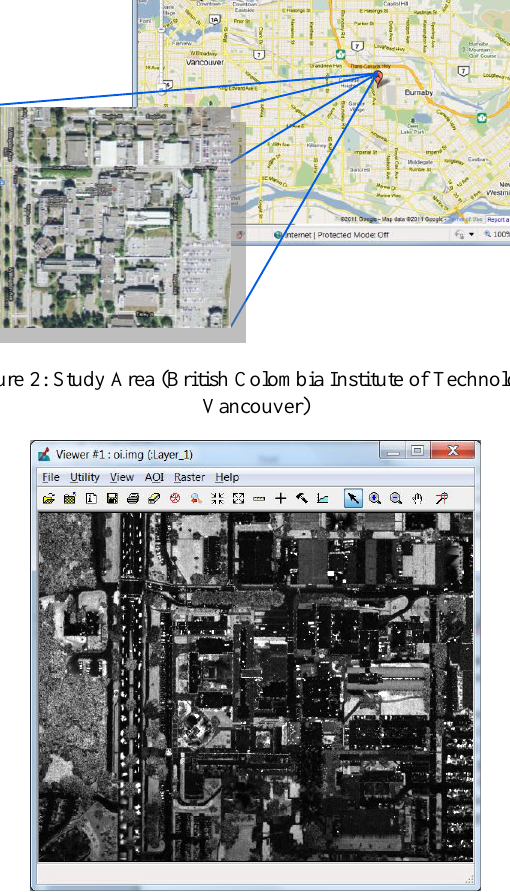
Figure 3: Raster Image of the Original LiDAR Intensity Data